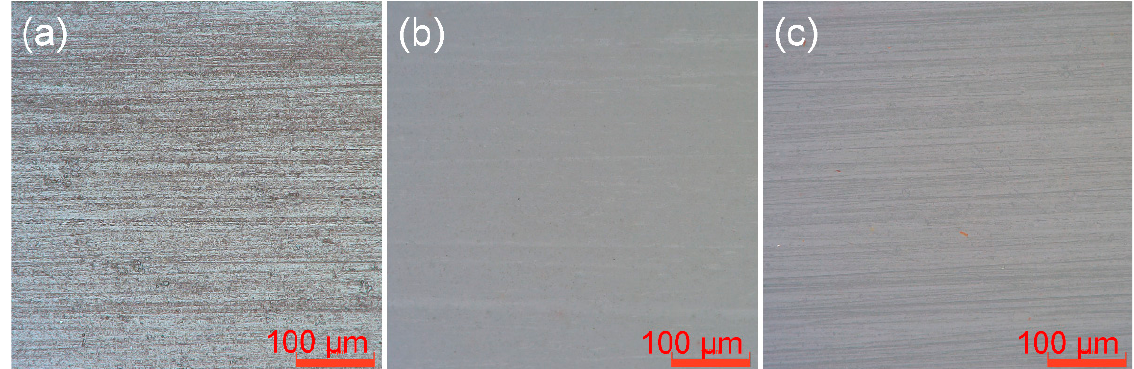
Figure 7. Surface microstructure of different materials: ( a ) cured pure resin; ( b ) ceramic; ( c ) hybrid polymer–ceramic material. Table 2. The surface roughness of different materials.